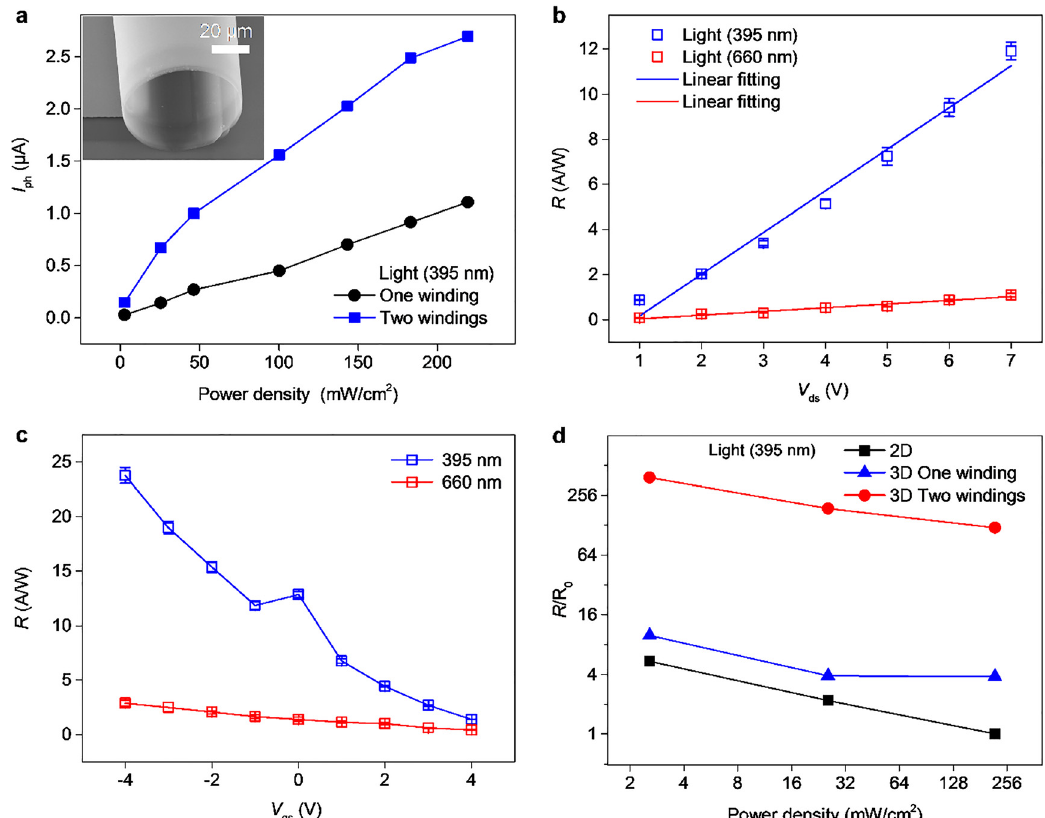
Figure 4: Photoelectrical properties of the 3D MoS 2 FET photodetectors. (a) Dependence of photocurrent on light power density with different rolled-up winding numbers at V ds = 8 V and V gs = 0 V under 395-nm illumination.TheinsetshowsthesideviewoftheSEMmicroimageforthe3DMoS 2 FETwithtworolled-upwindings;(b)photoresponsivitiesof the device with two windings at different source – drain voltages, in which V gs is 0 V; (c) the relationship between gate voltage and photo- responsivity, in which V ds is 5 V; (d) the normalized photoresponsivities of 2D and 3D MoS 2 FET photodetectors at different light power densities,where R 0 isthephotoresponsivityofthe2DMoS 2 FETat V ds =6V, V gs =0Vandlightpowerdensityof219mW/cm 2 .Thedimensionof the conductive channel for the 2D MoS 2 FET is 30 μ m × 200 μ m (length × width). 2D, two-dimensional; 3D, three-dimensional; FET, fi eld-effect transistor; MoS 2 , molybdenum disul fi